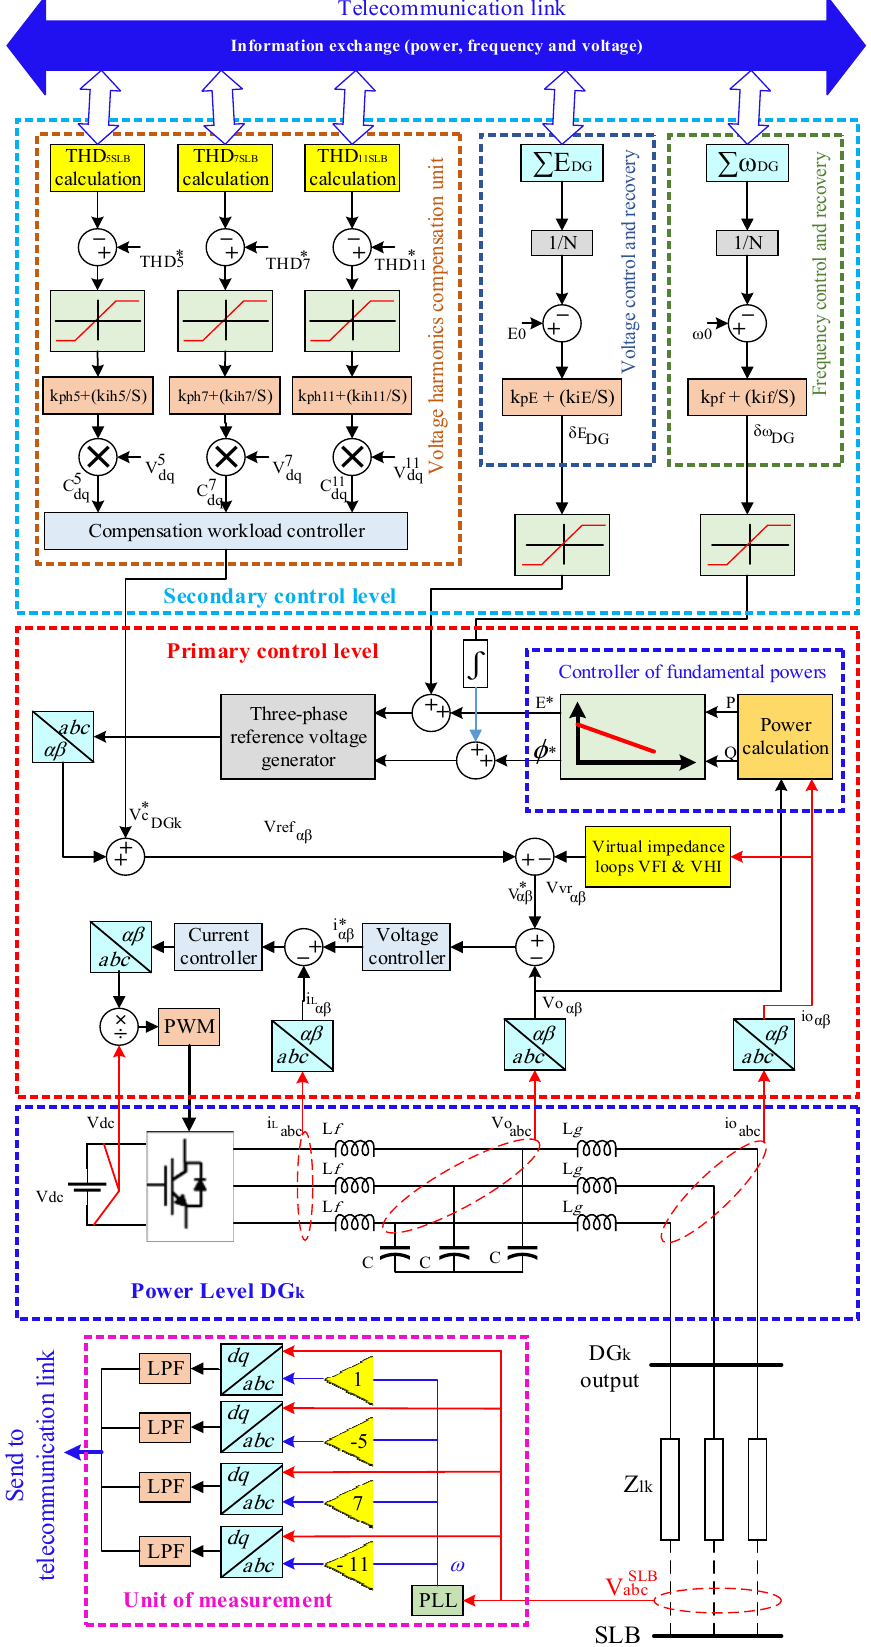
Figure 2. Details of the primary and secondary controller of the